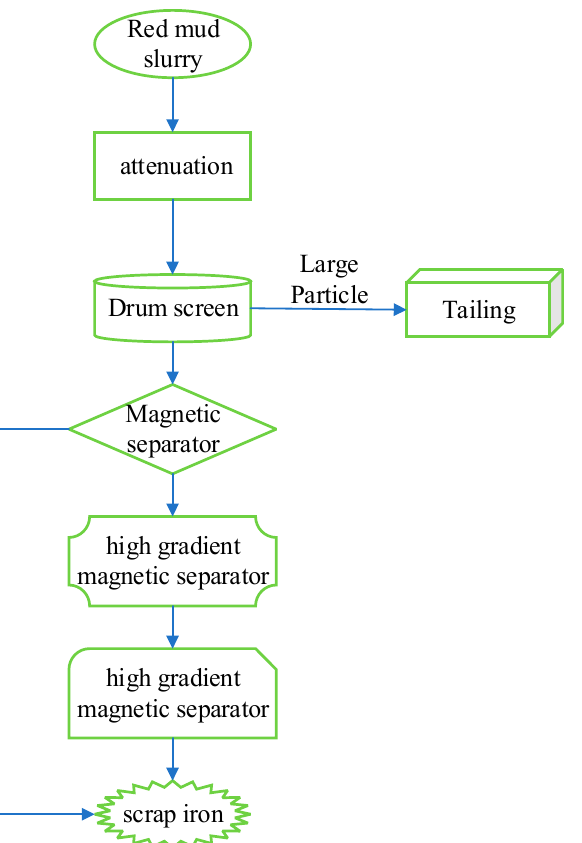
Figure 12. Iron extraction from Bayer RM by direct magnetic separation in Pingguo Aluminum Company [42].